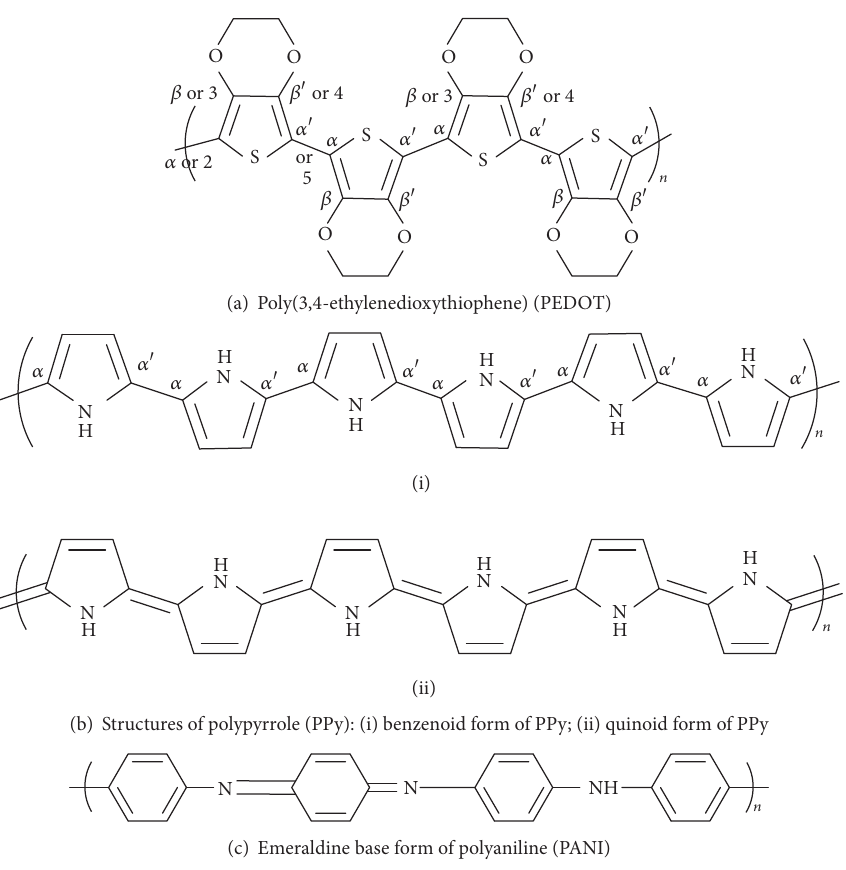
Figure 1: Chemical structures of conducting polymers (a) poly(3,4-ethylenedioxythiophene) PEDOT, (b) PPy, and (c) polyaniline PANI.